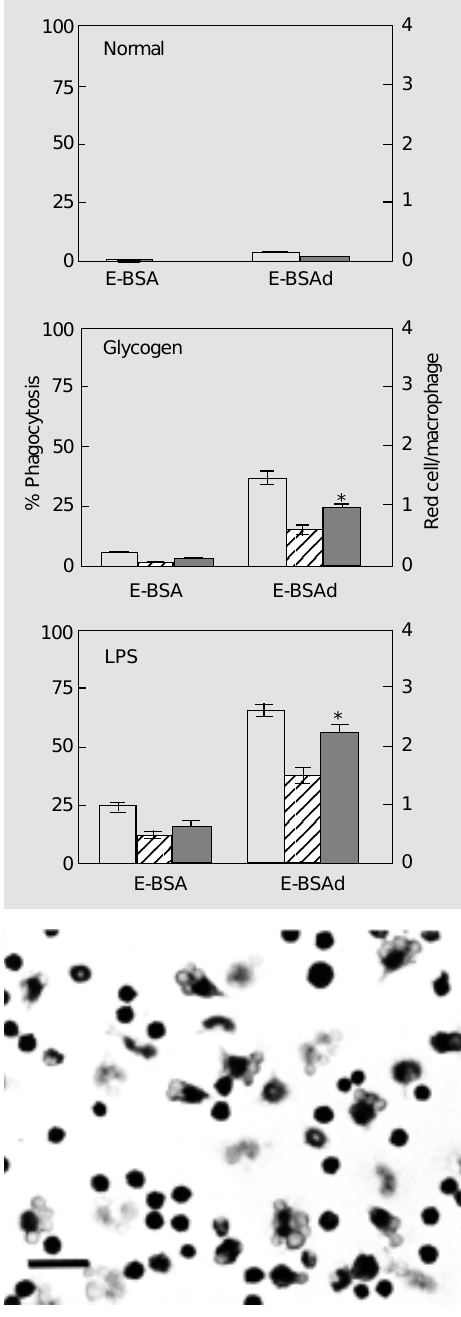
Figure 3. Phagocytosis of E- BSAd (red cells covered with denatured BSA) by macro- phages from the inflammatory exudate induced by glycogen. The experimental conditions are the same as in Figure 2. Bar